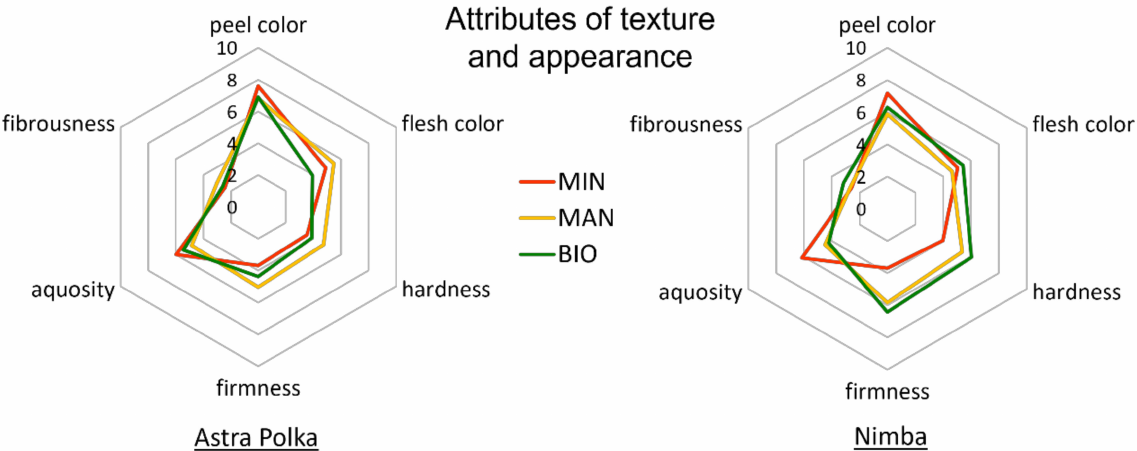
Figure 4. Intensity of texture and appearance attributes of courgette fruits of Astra Polka and Nimba cultivars grown in horticultural system with commercial organic fertilizer (BIO), manure (MAN), and mineral (MIN)